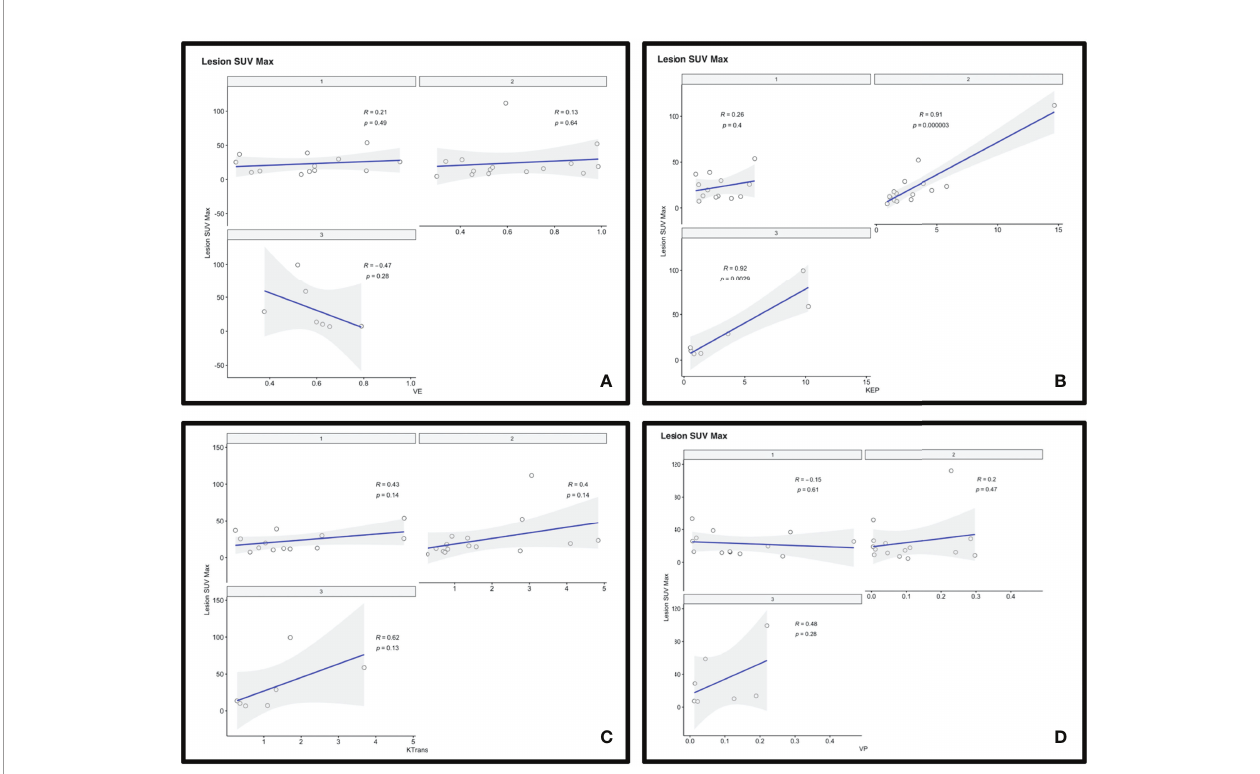
FIGURE 3 | Scatterplots depicting the correlation between 68-Gallium-DOTATATE PET SUV and DCE perfusion parameters Ve (A) , Kep (B) , Ktrans (C) , and Vp (D)